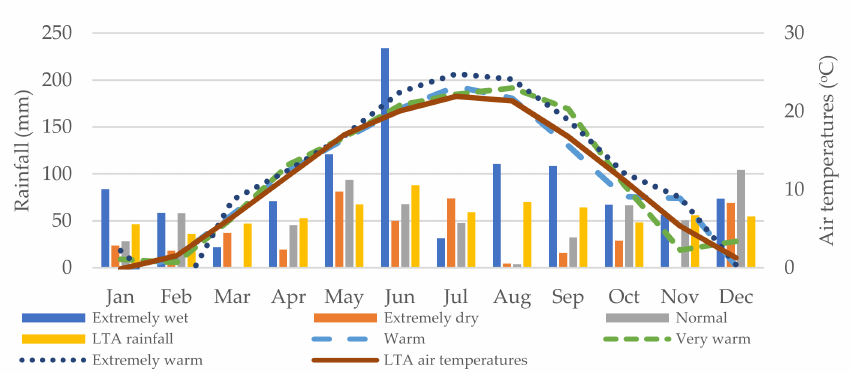
Figure 2. Rainfall (mm) and air temperatures ( ◦ C) during the study period and the long-term average (LTA, 1981–2010).